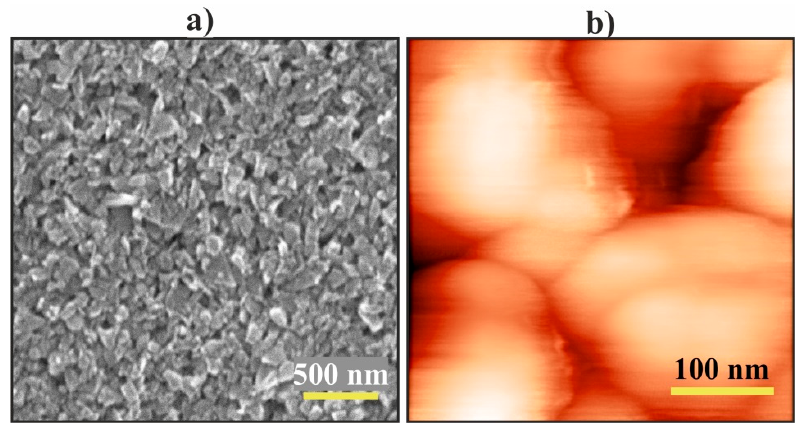
Figure 3. Scanning electron microscopy (SEM ( a ) and atomic force microscopy (AFM) ( b ) images of the HP-HT nanodiamond film surface.